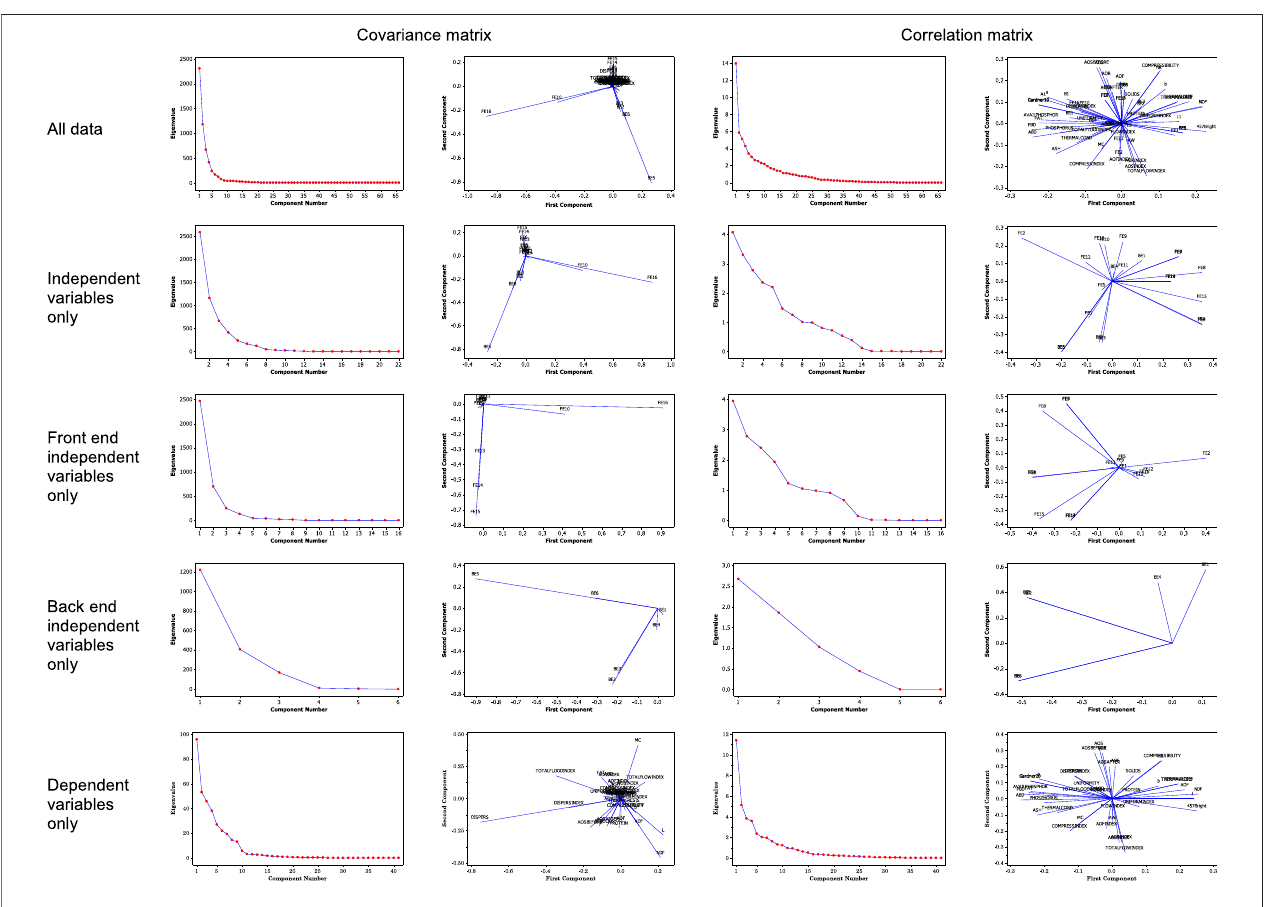
FIGURE 6 | Error and loading plots for Principal Components Analysis